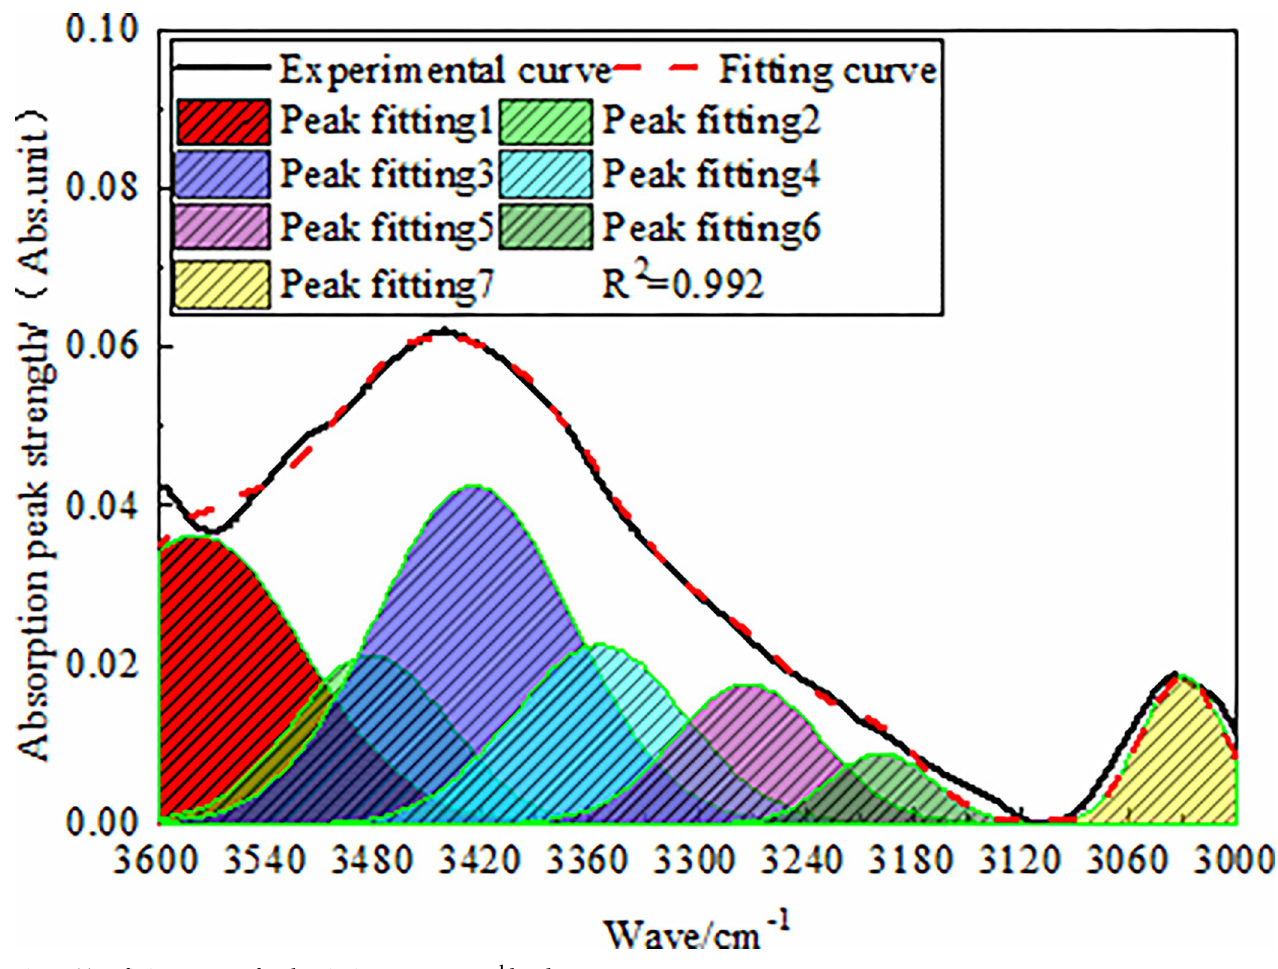
Fig 5. FT-IR fitting spectra of anthracite in 3600–3000 cm -1